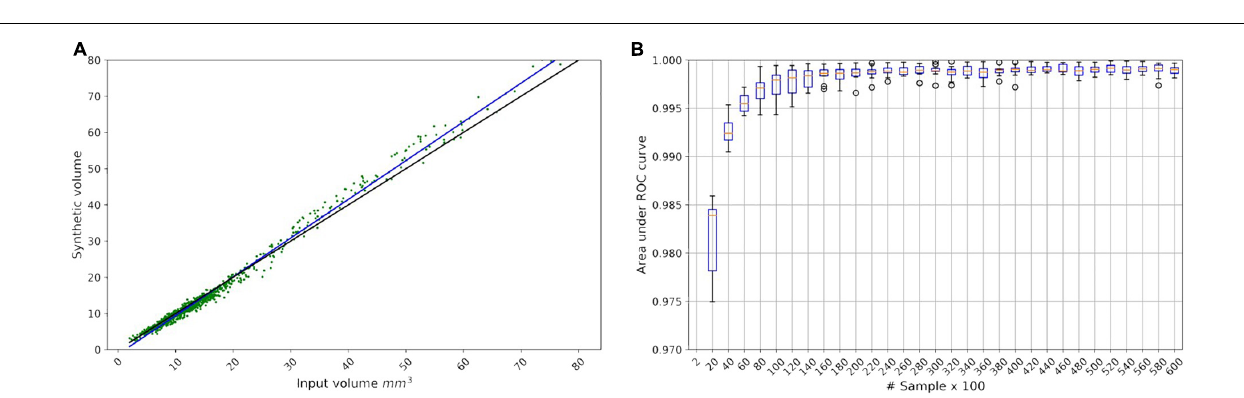
FIGURE 5 | (A) Linear regression model for the LesionGAN by deploying volume value as a condition. The black line is identity line; the blue line is the fitted linear model ( y = 1.07 x - 1.28) between real and generated volumes. The green scatter points show the generated synthetic volume for each input volume. (B) Area under the receiver operating characteristic curve from saturating the classifier by applying 60,000 samples in 30 steps, each step adding 2,000